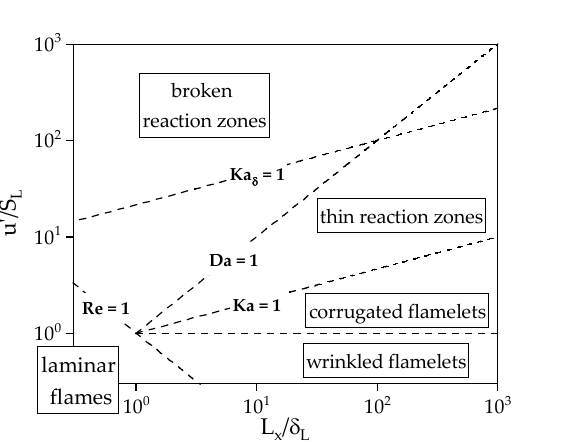
Figure 12. Regime diagram of turbulent premixed combustion according to Peters [47]. The dashed line represented by a Karlovitz number of one separates the corrugated flamelets, where the smallest eddies cannot enter the flame, from the regime of thin reaction zones. For Ka > 1, the smallest eddies enter the flame, which leads to a perturbation of the flame and influences scalar and temperature gradients. However, in the regime of thin reaction zones, the smallest eddies cannot penetrate into the reaction zone and do not influence the chemical processes. Peters [47] introduced a second Karlovitz number, Ka δ , where the laminar flame thickness in Equation (9) is replaced by the thickness of the reaction zone, which is usually in the range of one-tenth of the flame thickness. Ka δ = 1 functions as an upper bound for the regime of thin reaction zones. Above this limit, the eddies enter the reaction zone and affect the chemical reactions in the regime of broken reaction